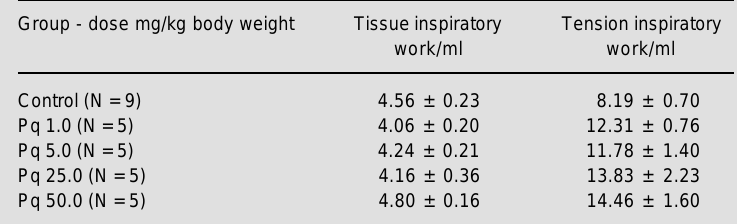
Table 1 - Inspiratory work/ml attributable to tissue and surface tension for the control group and paraquat (Pq) group. Data are reported as means ±